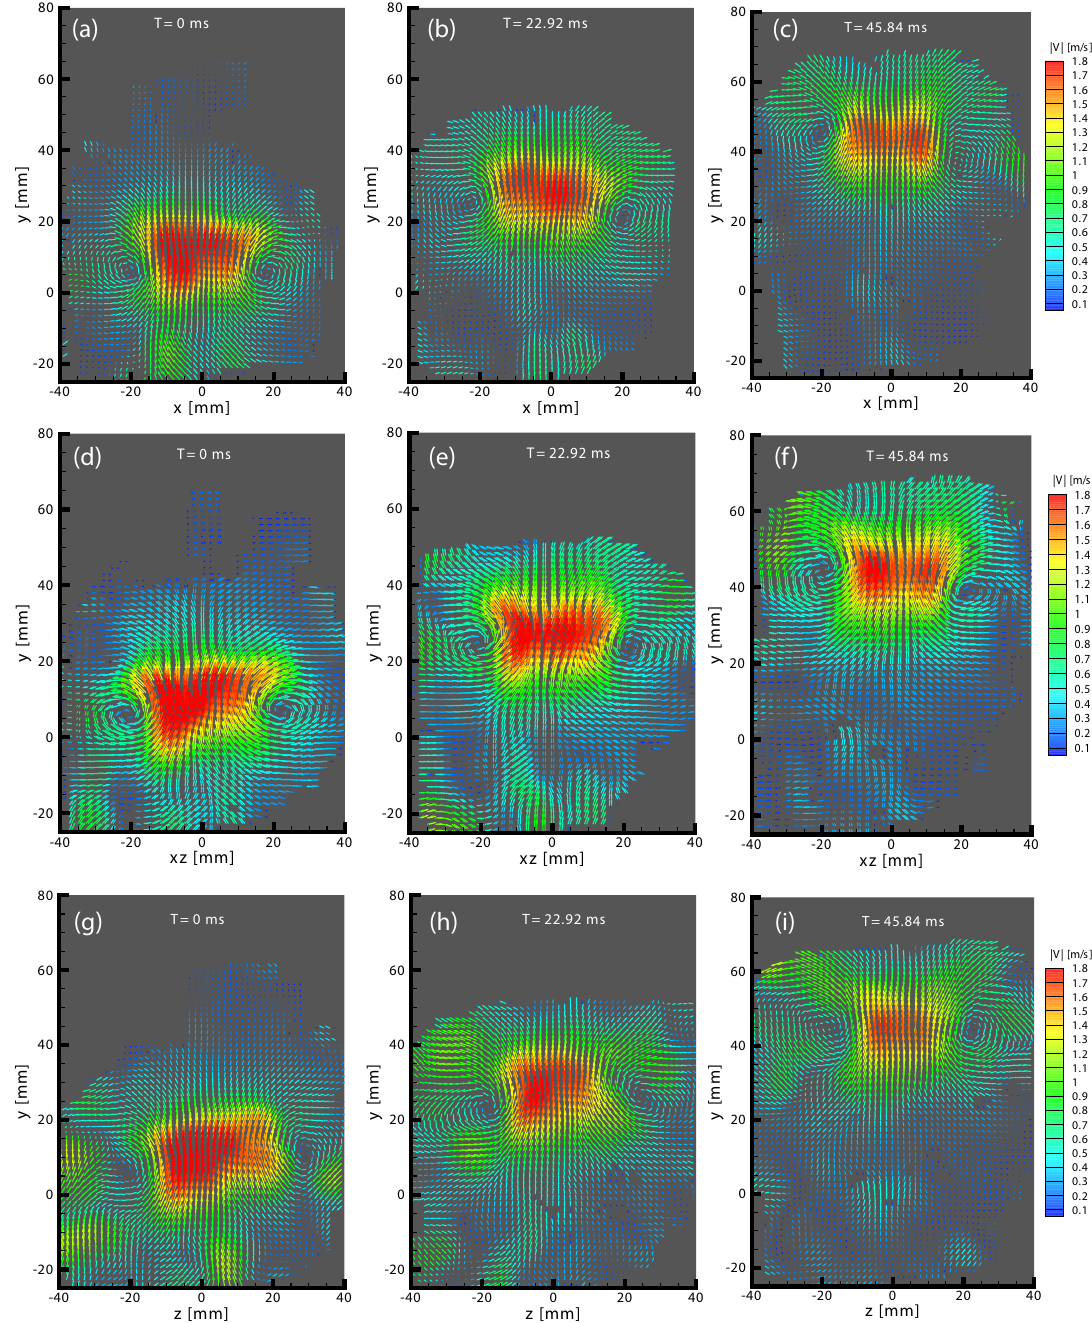
Figure 5. ( a – c ) Two dimensional xy cuts through the center of the vortex ring, showing the instantaneous velocity field. ( d – f ) Two dimensional vertical cut of the instantaneous velocity field in a 45-degree xz plane. ( g – i ) Two-dimensional yz cut of the instantaneous velocity field at the center of the vortex ring (note that this plane is not directly visible and is perpendicular to the central camera sensors). Different times are plotted from left to right (0, 22.92 and 45.84 ms respectively, showing the upward translation of the vortex ring). Vectors are colored by their velocity